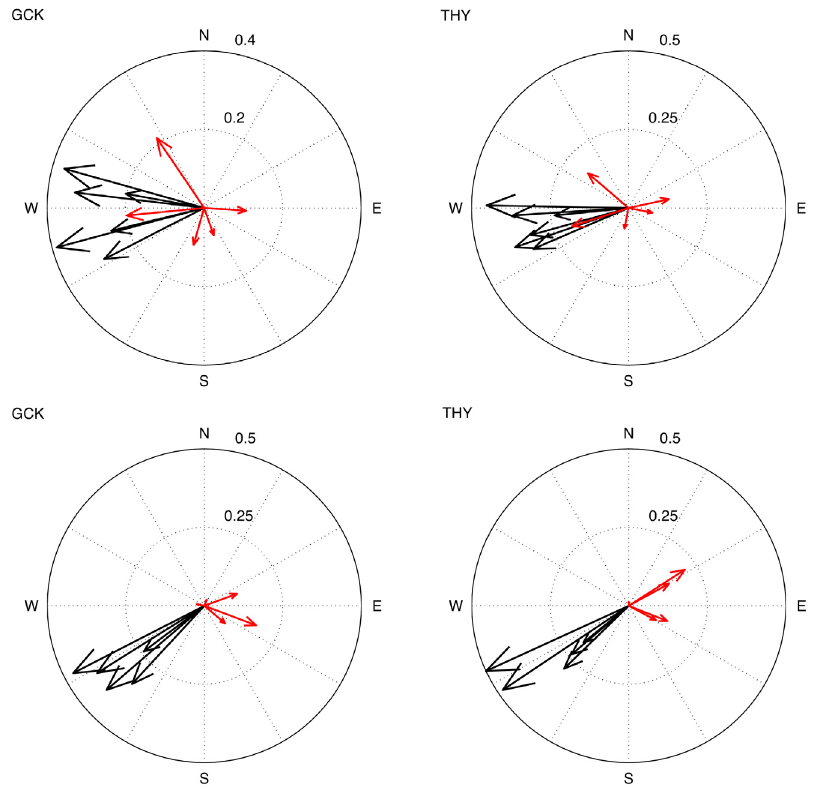
Figure 3. (a) Real (black) and imaginary (red) induction arrows for KRBP, with GCK and THY as reference points. These arrows have been ob- tained for periods of 10.7 min, 12.8 min, 18.3 min, 25.6 min, 32.0 min and 64.0 min. (b) Real (black) and imaginary (red) induction arrows for SINP, with GCK and THY as reference points. These arrows have been obtained for periods of 12.8 min, 18.3 min, 21.3 min, 42.7 min and 64.0 min.